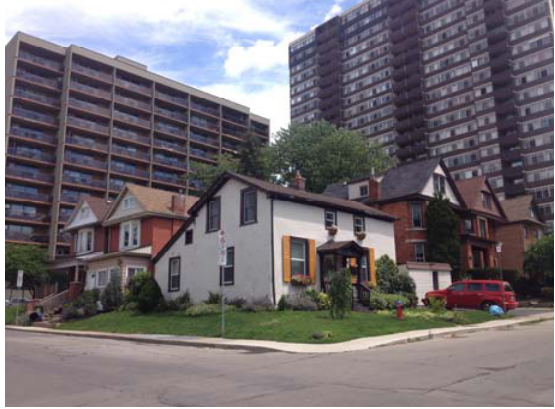
Figure 4. Varied building styles, scales and eras in